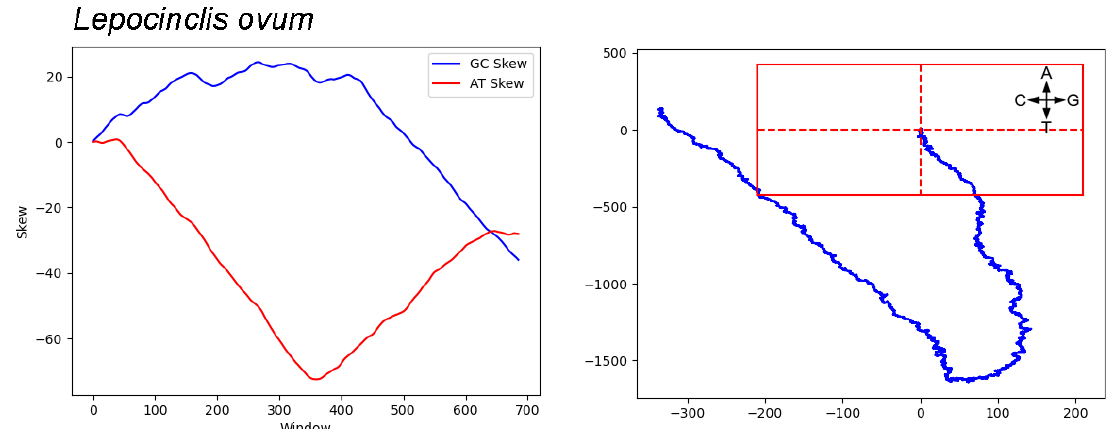
Figure 3. Cumulative skews and genome walk of intergenic regions from the euglenozoa Lepocinclis ovum . The skew was calculated using a window size of 1000 and an overlap of 100. The origin of the walk is the intersection of the dashed red lines and the outer box represents the significance point as described in Section 2. For the genome walk, the direction of change for each base is indicated; the AT walk is on the vertical axis and the GC walk along the horizontal axis.